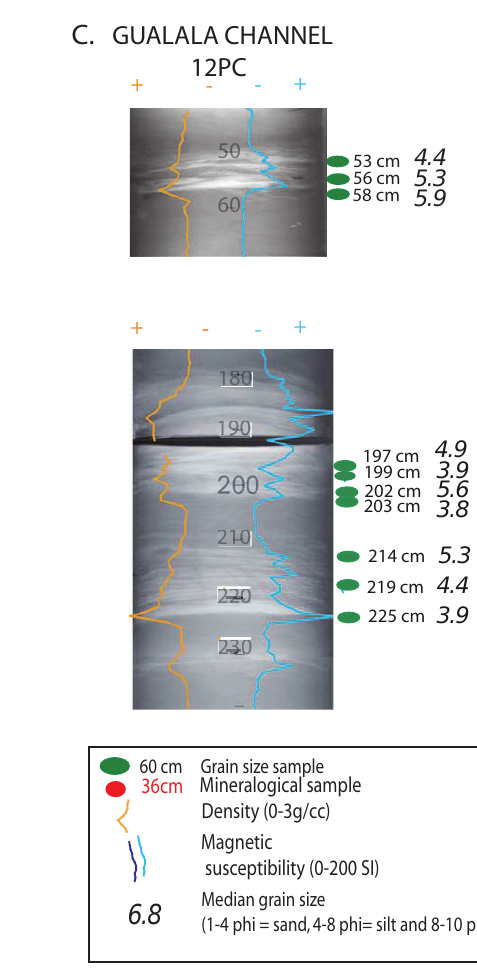
Fig. 9. Northern California margin core sections from (A) 13PC in Gualala Canyon mouth, (B) 12PC in Gualala Channel downstream from 13PC tributary site, and (C) 24GC below Noyo/Gualala/Viscaino channel confluence. Core figures show X-ray radiographs, physical properties (density and magnetic signatures), grain size and mineralogy. Green dots are the grain size sample locations and numbers besides the dots are the median grain size (d50) in a phi ( φ) scale for each sample. Red dots key mineralogic sample locations for the mineral compositions of the stacked turbidites that are shown to the right or core 24GC. Heavy mineral compositions are a percentage of the total light and heavy mineral grains that were counted (mineralogy from Goldfinger et al., 2007). Grain-size analysis, compared with the X- ray radiography of cores and physical property logs, is used to distinguish turbidite pulses, determine presence or absence of hemipelagic sediment between pulses, and demonstrate that magnetic and density logs can be used as proxies of grain size because there is an excellent agreement between curves. Note in 13PC that two uni-pulsed turbidites are separated by 7 phi hemipelagic sediment. Note in 12PC that stacked turbidites from individual earthquake events show irregular grading of grain size and have no 7 phi hemipelagic sediment between turbidites. Note in 24GC that each stacked turbidite has a specific mineralogy correlated with different tributary canyon mineral sources. (Figure is modified from Guti´errez Pastor et al.,